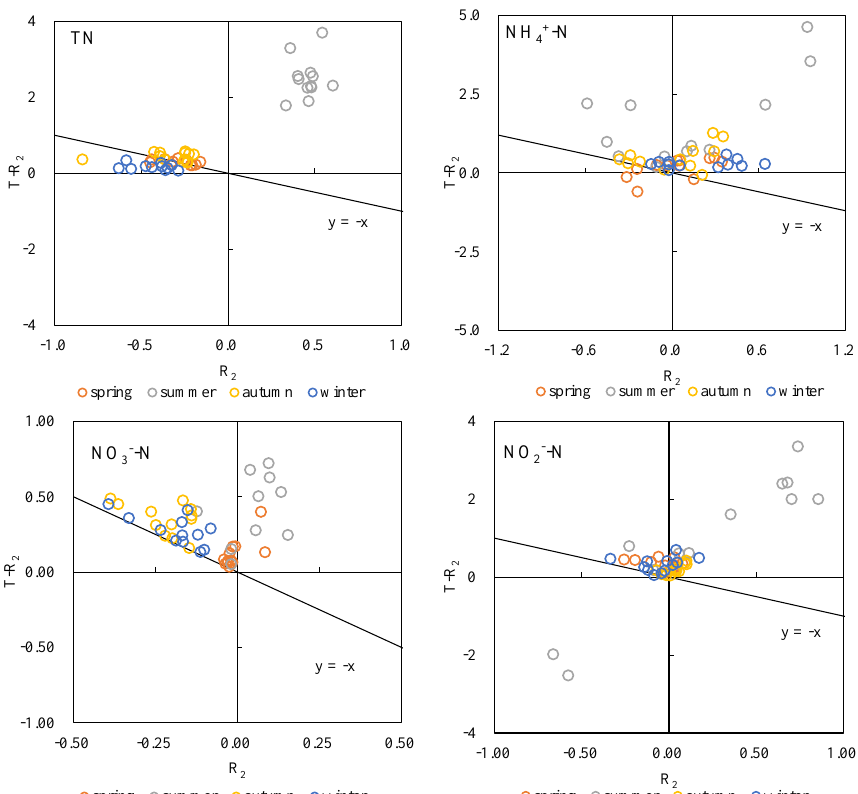
Figure 4. Scatterplot of T-R 2 (theoretical rate of change of bottom N concentrations, y -axis) vs R 2 (experimentally measured rate of change of bottom N concentrations, x -axis). Points lying on the y = −x line exhibit upper concentrations loss rates equaling bottom concentrations increase rates as a result of physical deposition in absence of microbial activity.